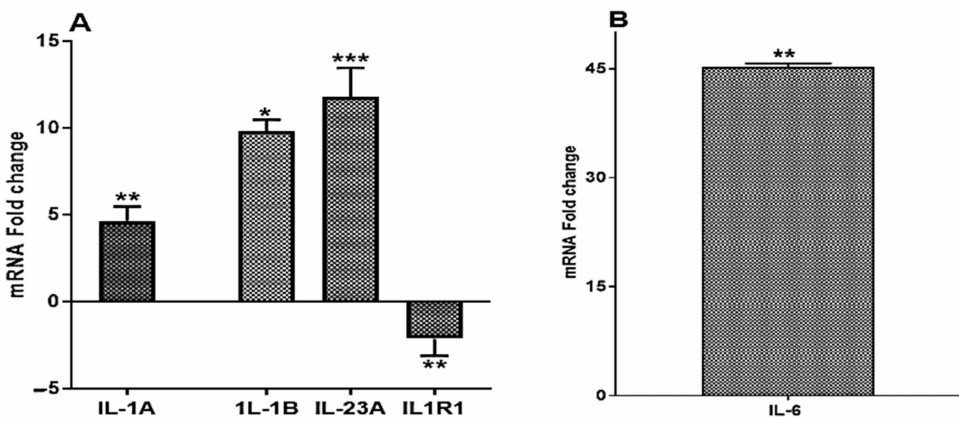
Figure 2. Effects of co-culturing ST285 with monocytes ( n = 3) on gene/RNA expression compared to control monocytes after 24 h. ( A ) IL-1 α , IL-1 β , IL-23 α , IL-1R1, and ( B ) IL-6 mRNA fold-change following a 24 h co-culture of ST285 with monocytes ( n = 3), compared to control monocytes. The innate and adaptive RT 2 gene profiler arrays were used to determine changes in gene expression. The symbols represent the p -value for Tukey’s test (one-way ANOVA) using the Statistical Package for the Social Sciences for Windows 25.0 (SPSS; Armonk, NY, USA: IBM Corp.), where * p < 0.05, ** p < 0.04 and *** p < 0.02.